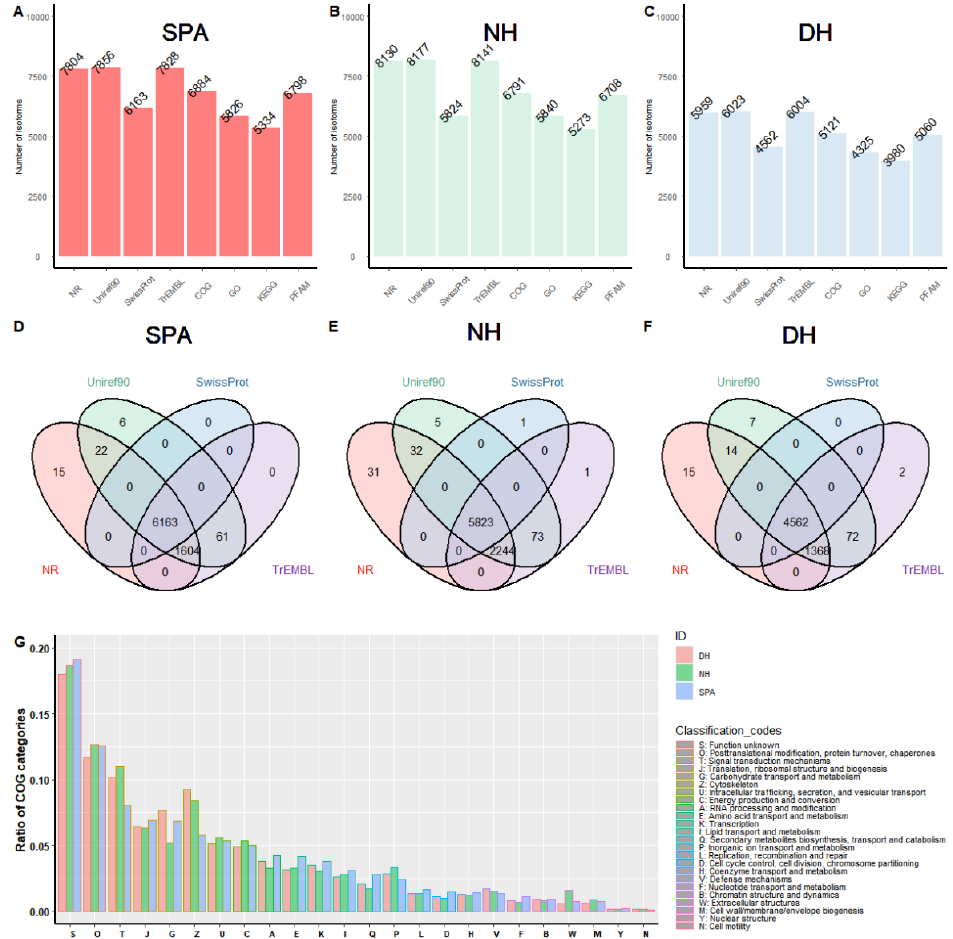
Figure 2. The summary of gene functional annotation using different databases. ( A – C ) Statistics of isoforms annotation results for SPA, NH, and DH using different databases including NR, Uniref90, Swiss-Prot, TrEMBL, COG, GO, KEGG, and PFAMs. The Y-axis represents the number of annotated isoforms. The X-axis represents different databases. ( D – F ) Venn diagrams showing the overlapping isoforms annotation results obtained using a different database for SPA, NH, and DH, respectively.